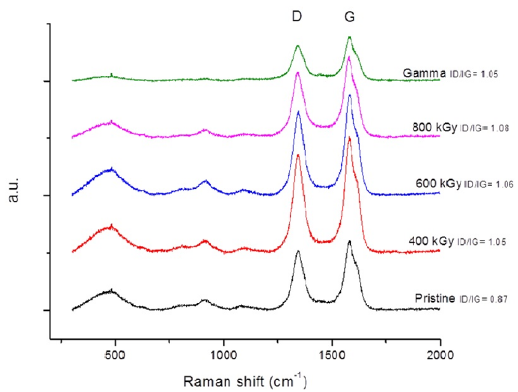
Figure 7. Raman spectroscopy results for CNTY pristine and CNTY e-beam irradiated at 400, 600, 800 kGy and gamma irradiated at 100